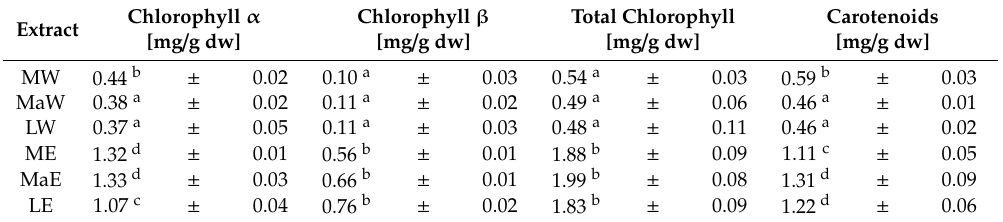
Table 1. The content of chlorophyll and carotenoids in Humulus lupulus L. hops